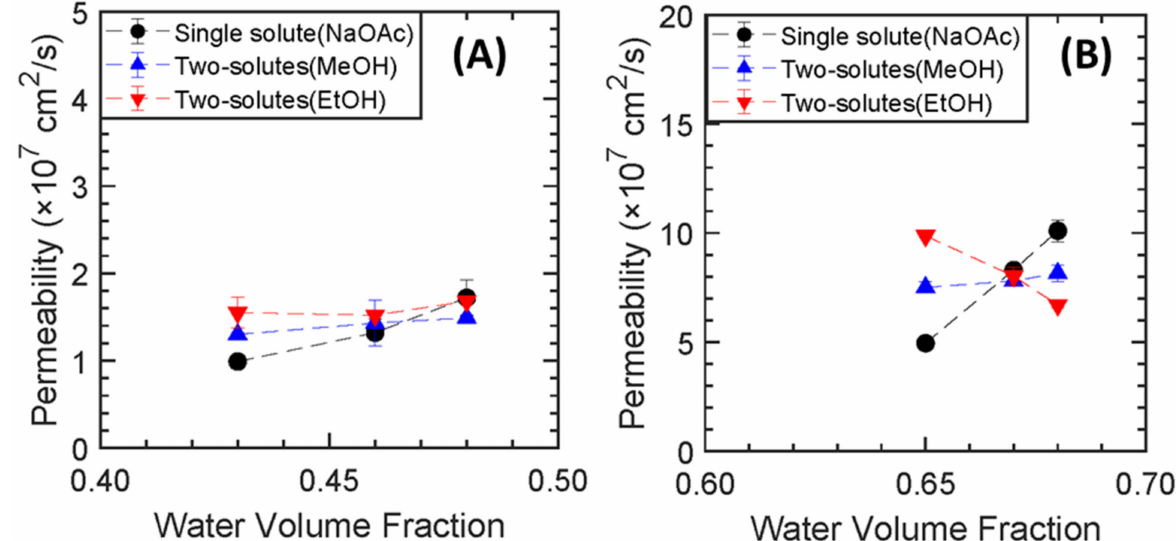
Figure 9. PEGDA-PEGMA (0, 16, 32 mol%) permeability to sodium acetate (NaOAc), in single and two-solute vs. varied PEGMA mol% at ( A ) 20% and ( B ) 60 pre − polymerization water